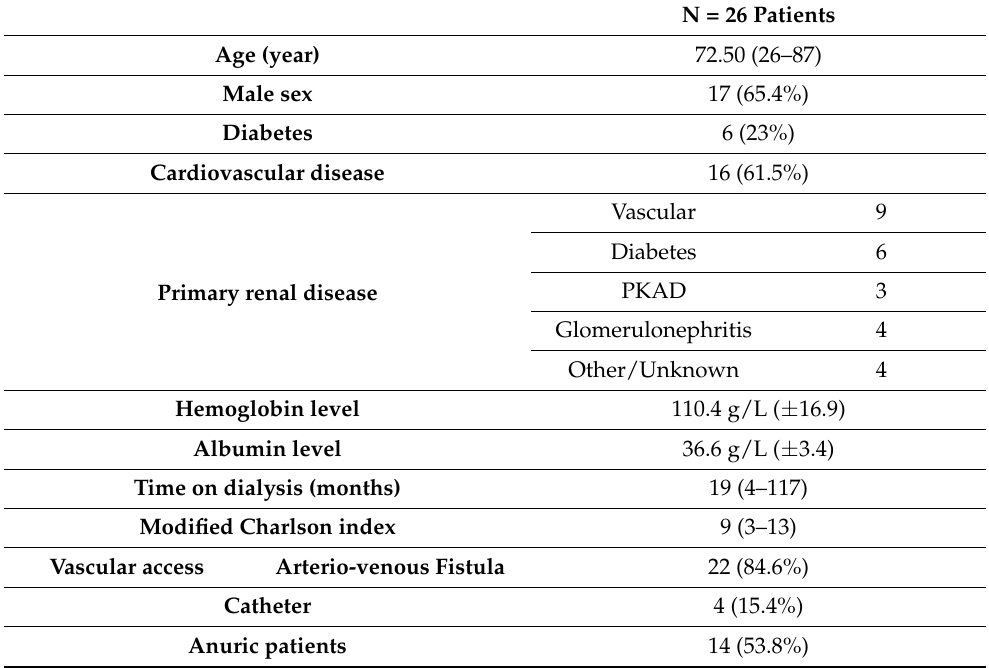
Table 1. Patients’